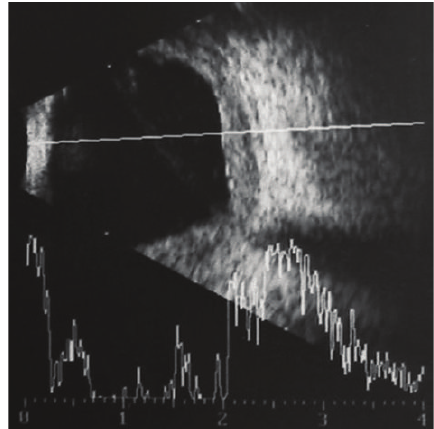
Figure 2: Ultrasound image of the posterior pole of the left eye. Note the thickening of the choroid, compatible with a di ff use choroidal hemangioma.